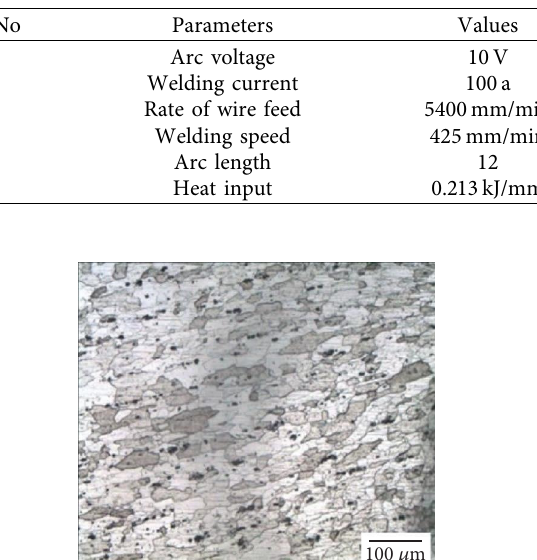
Table 4: PCMT welding parameters used in this investigation.